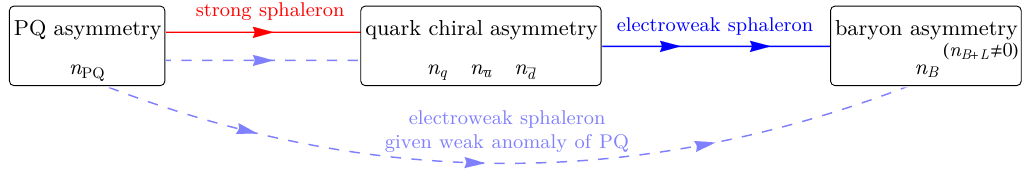
Figure 1 . Transfer of asymmetries for